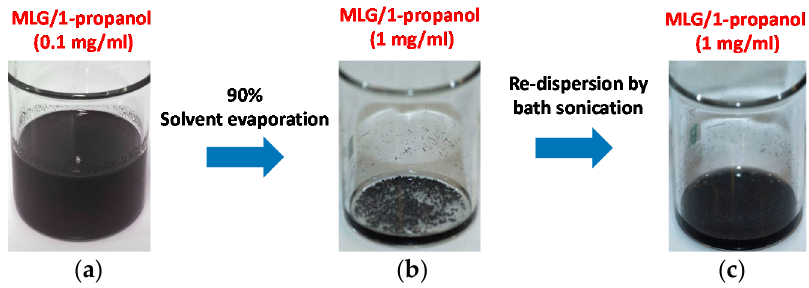
Figure 2. MLG suspension after: ( a ) ultrasonication, ( b ) solvent evaporation and ( c ) re-dispersion step.